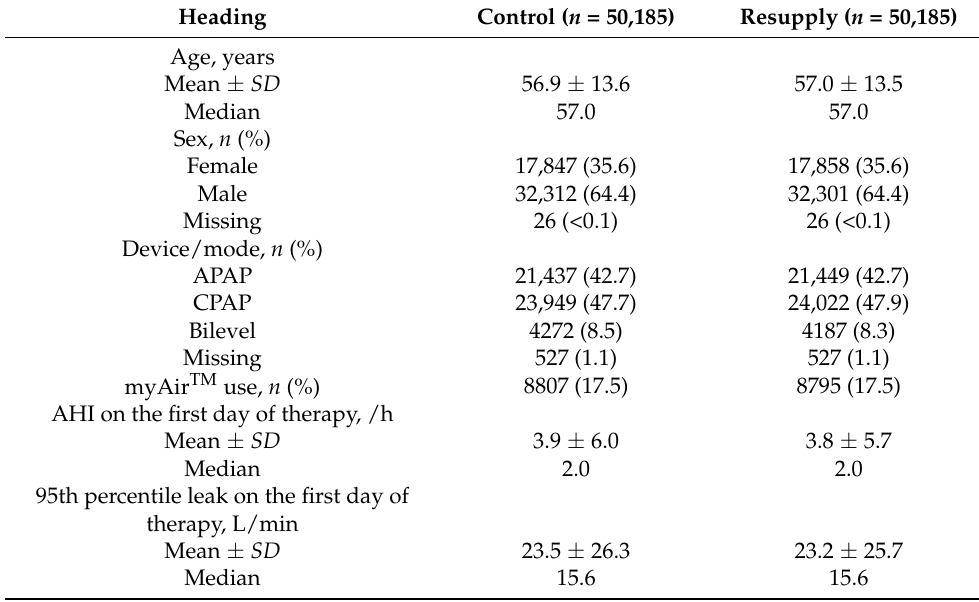
Table 1. Demographics and therapy characteristics for the primary analysis population.